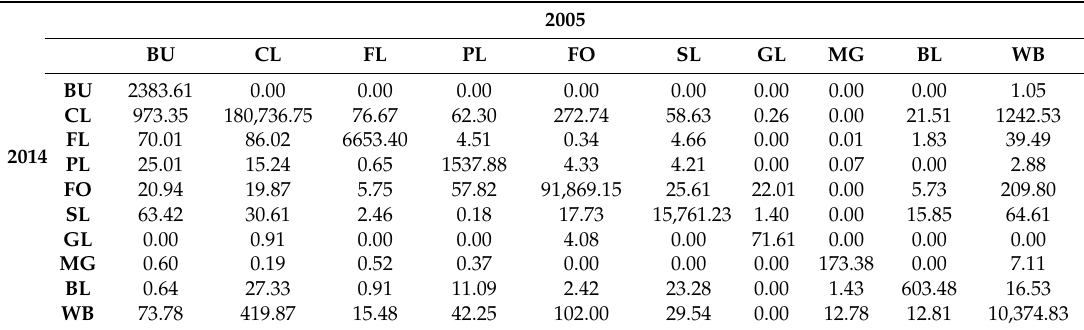
Table 5. Change detection matrix of